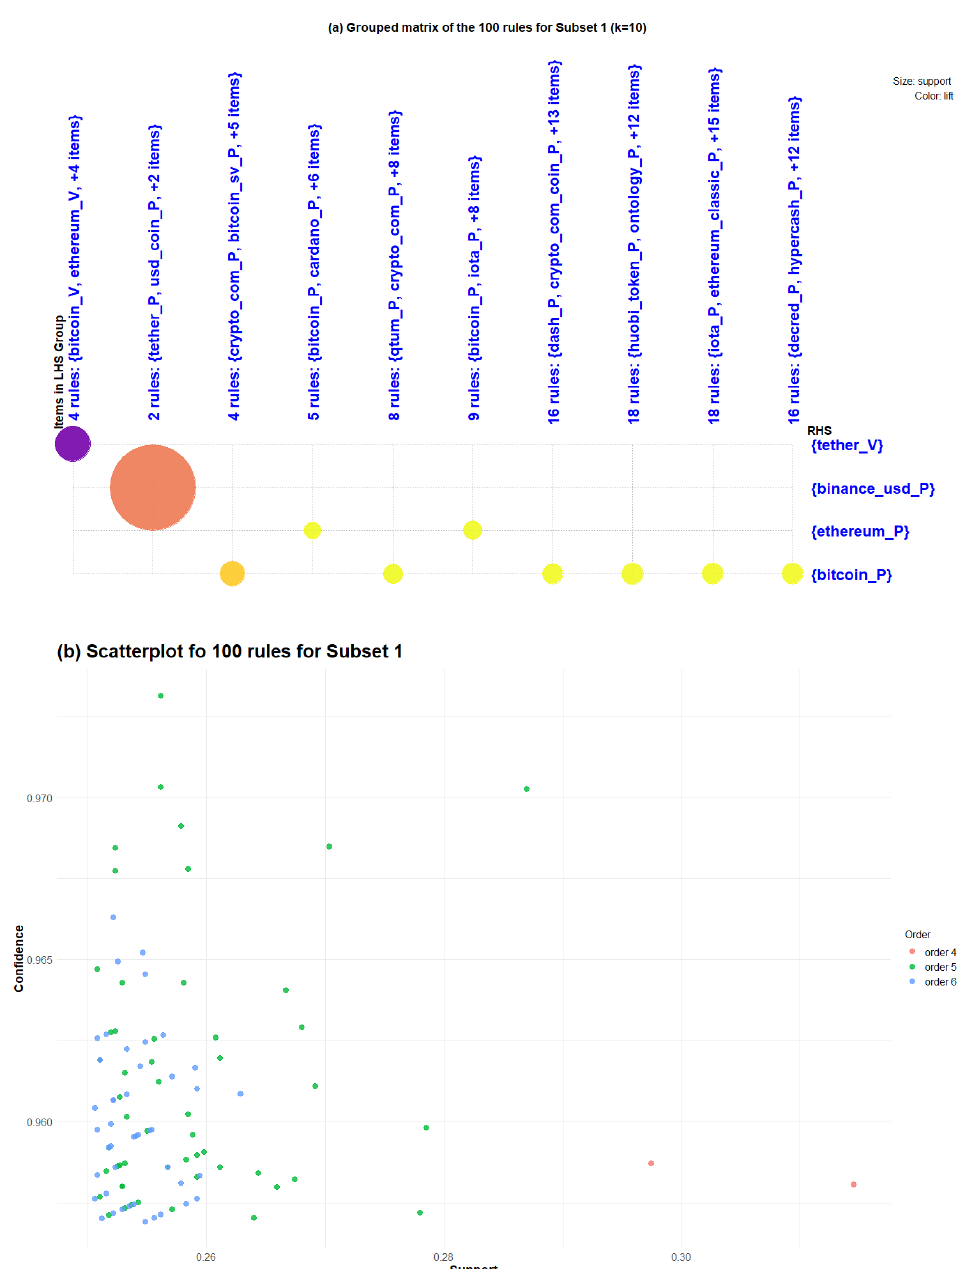
Figure 3. ( a ) Group matrix-based plot on 100 rules of Subset 1 with k = 10 groups, ( b ) Scatter plot of the rules for Subset 1 colored by order (LHS +